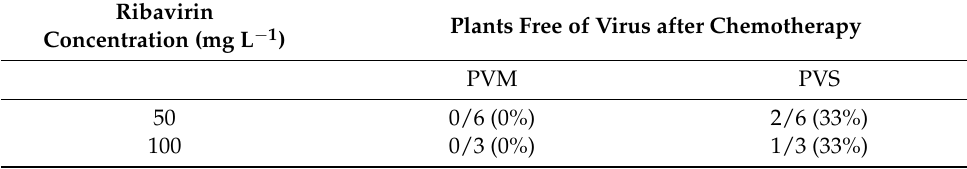
Table 4. The efficiency of virus elimination by ribavirin from potato cultivar